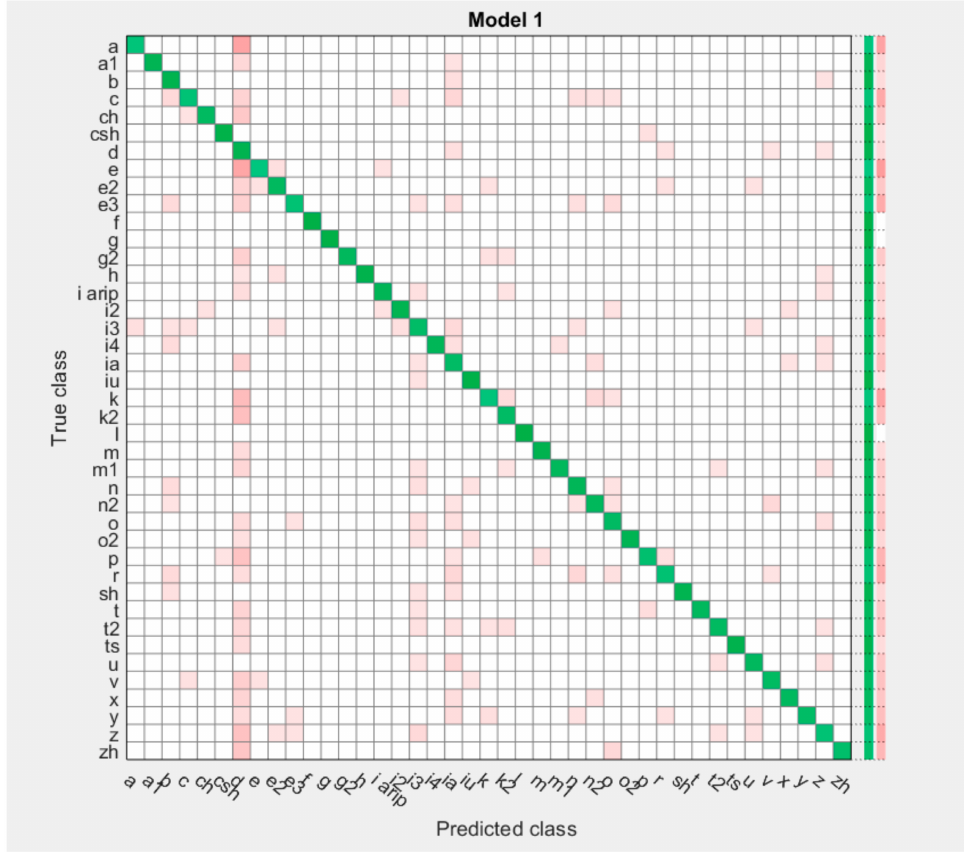
Figure 19. Confusion Matrix of the Kazakh dactylic